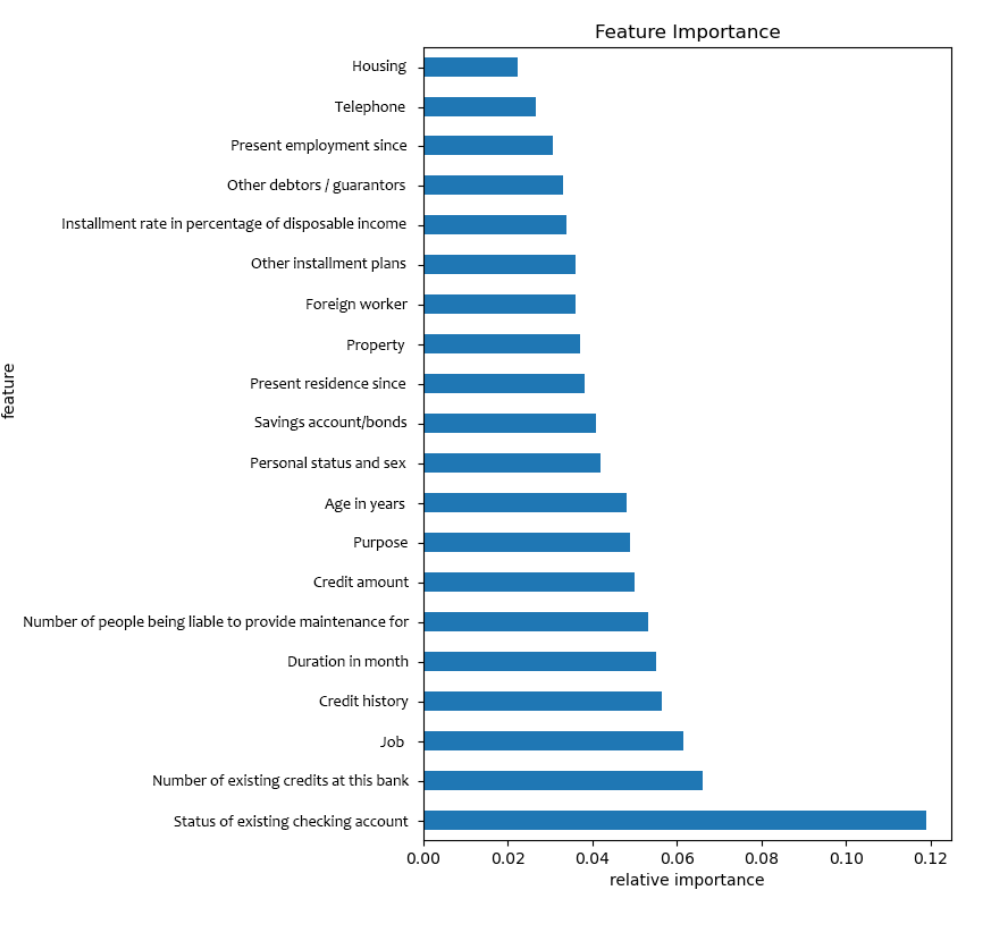
Figure 3. Relative feature importance on German credit